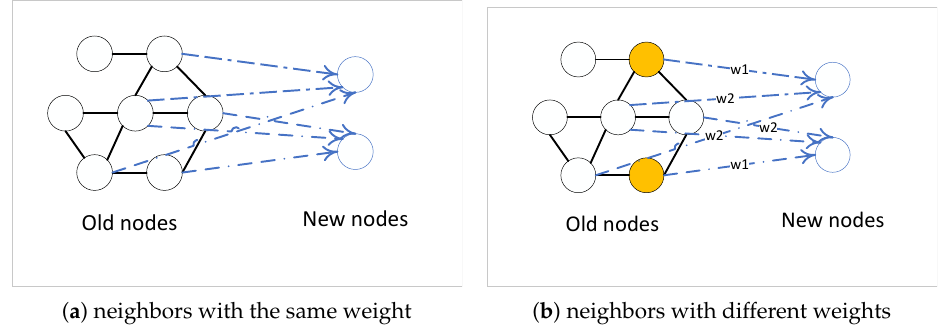
Figure 3. Inductive learning task. Here the node embeddings of new nodes are achieved by aggre- gating existing nodes’ embeddings. ( a ) assumes that all neighbors are of the same role, while ( b ) first distinguishes which nodes are important, thereby assigning greater weights during